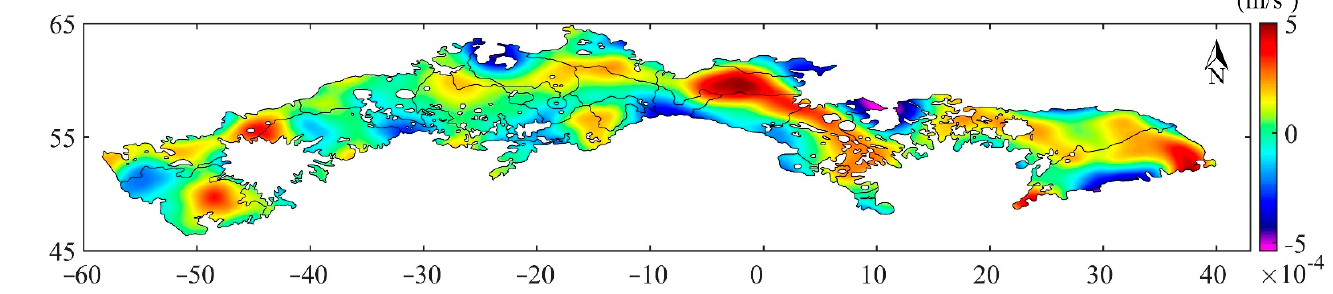
Figure 9. Bouguer gravity anomaly of Mare Frigoris (equidistant cylindrical projection). The black lines are the basaltic unit boundaries of Mare Frigoris mapped by Kramer et al. [2].